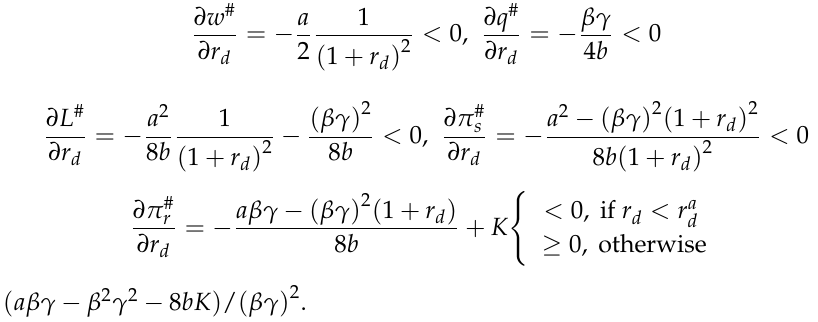
Figure A3. The schematic profit function of the supplier for Case A7.